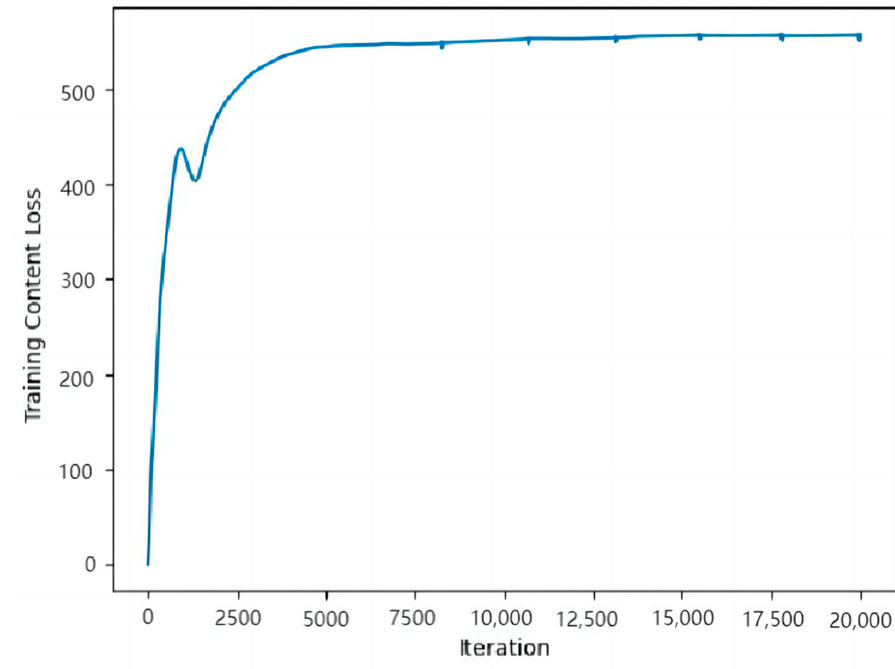
Figure 9. Content map loss function curve.